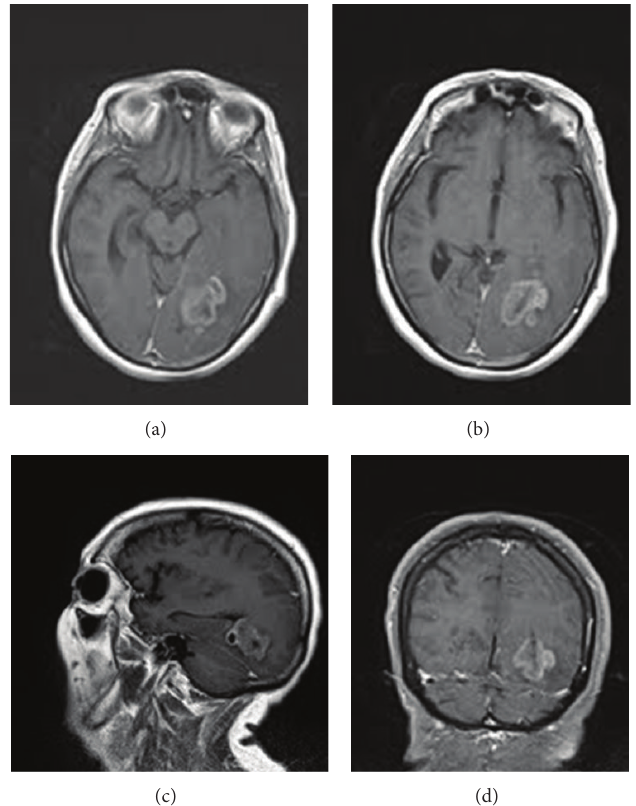
Figure 1: Initial brain MRI. (a), (b) Axial T1-weighted image with gadolinium, showing the enhancing intra- and periventricular left occipitotemporal mass. There is minimal mass effect. In (b) there is a suggestion of a “daughter cyst” lateral to the main lesion. (c) Sagittal T1-weighted image, with gadolinium, showing the lesion mostly within the occipital horn of the lateral ventricle. (d) Coronal T1-weighted image with gadolinium. The abnormal tissue involves the parenchyma around the ventricle as well as within the lumen.